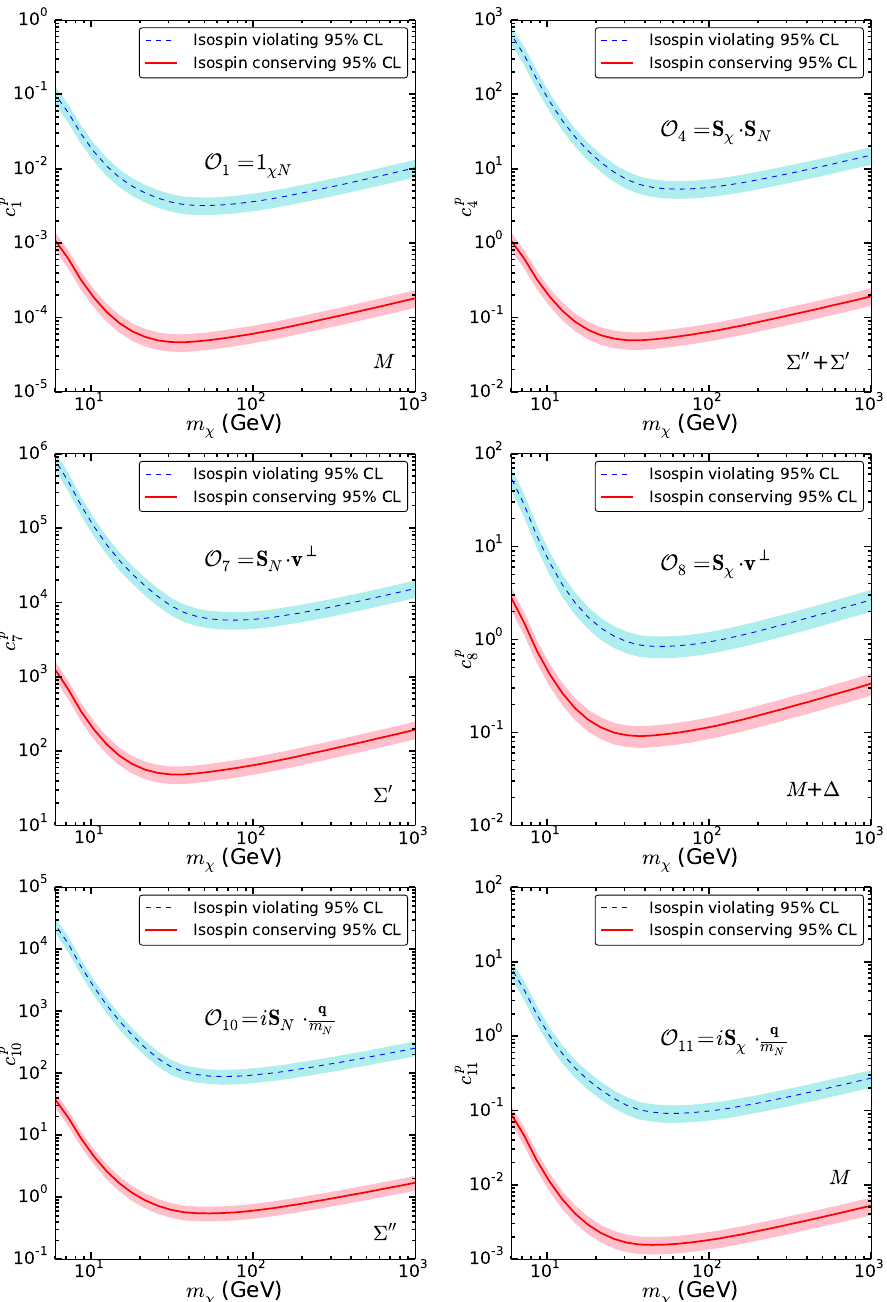
Figure 2 . The combined 95% CL upper limits for non-relativistic operator coe(cid:14)cients of O 1 , O 4 , O 7 , O 8 , O 10 , and O 11 . The red solid lines and blue dashed lines are for the ISC and ISV scenarios, respectively. The color bands demonstrate the uncertainties of the local DM density measurements [53].